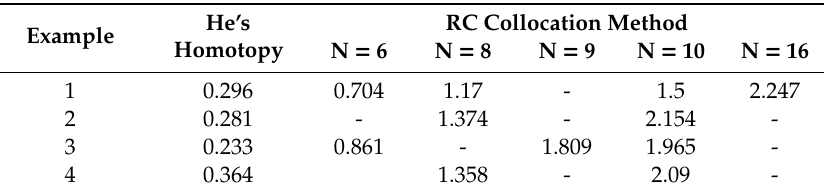
Table 15. The CPU time used for all